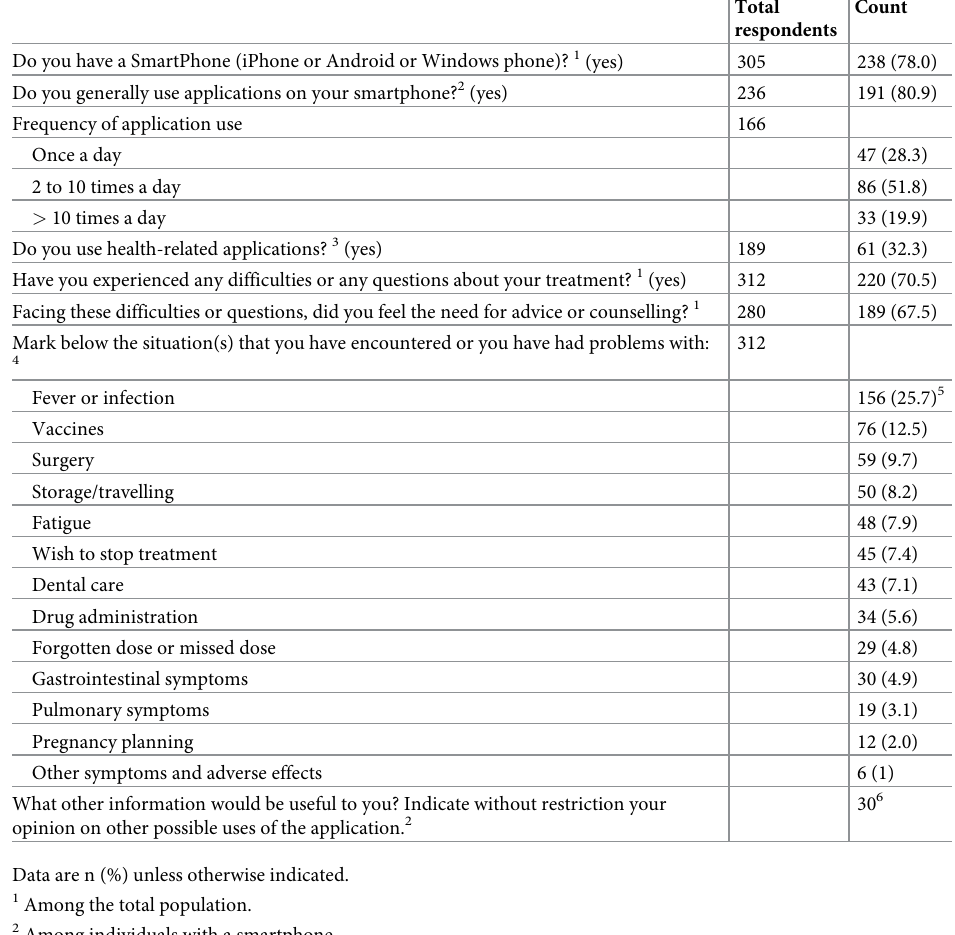
Table 2. Quantitative study: Smartphone use, difficulties encountered and information needs in daily life (n =